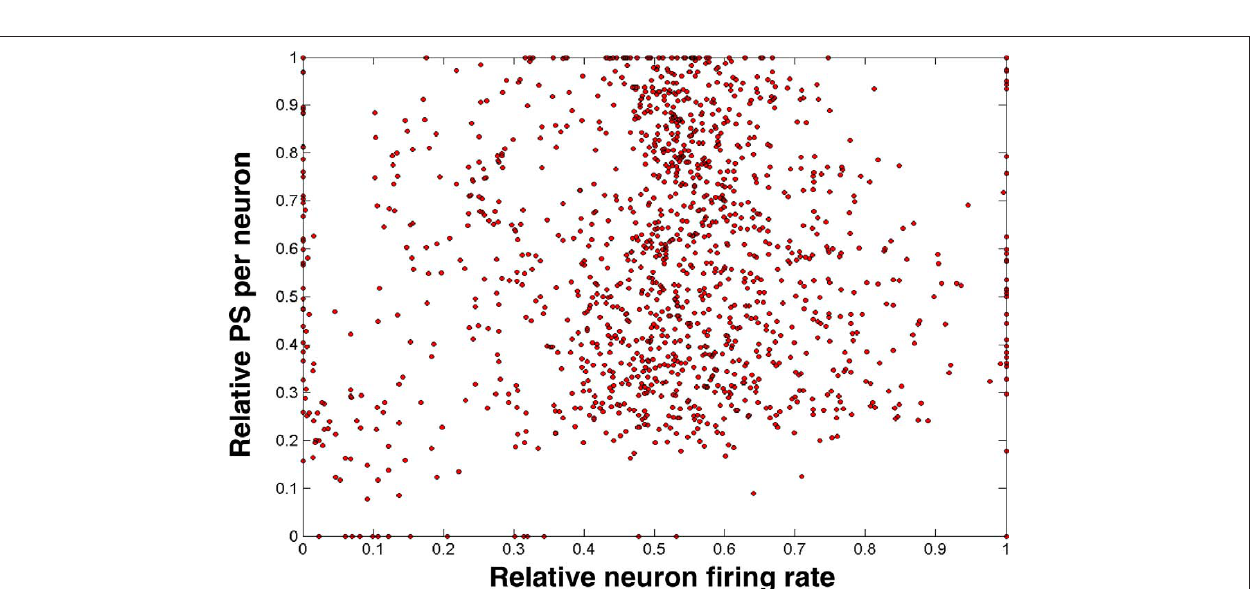
Figure A1 | Comparison of relative phase synchronization to relative firing rates, per neuron. In this plot each point represents one neuron in one recording frame. Data belong to a typical recording (WT2, untreated). Although